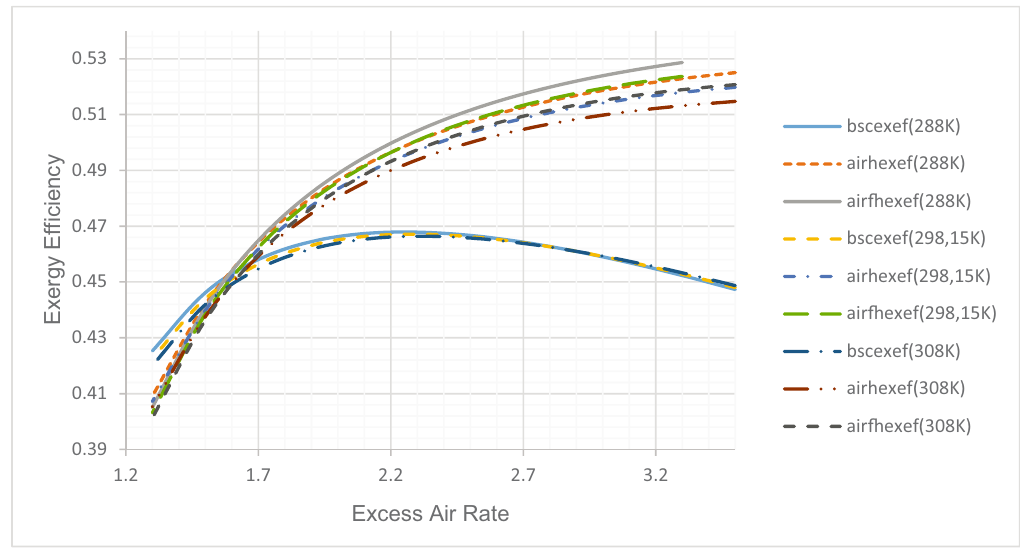
Figure 8: Variation of exergy e ffi ciency with air excess coe ffi cient at di ff erent compressor inlet temperatures for basic ( bsc ) , absorption cooling ( ab ) , air ( airh ) , and air fuel ( airfh ) heating cogeneration cycles ( m fuel = 1.64 kg/h, η isC = η isT = 0.86, r = 10, T recout = 850 K, T steam = 485.57 K, and T Exh = 426 K ) .